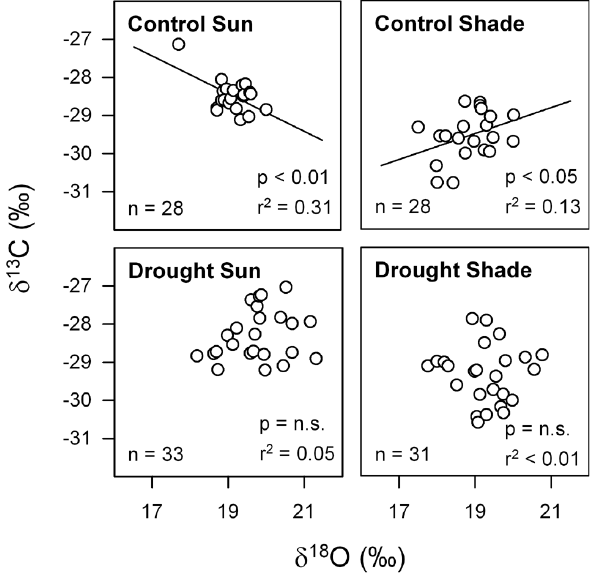
control and drought-exposed trees, and in leaves from the sun and shade